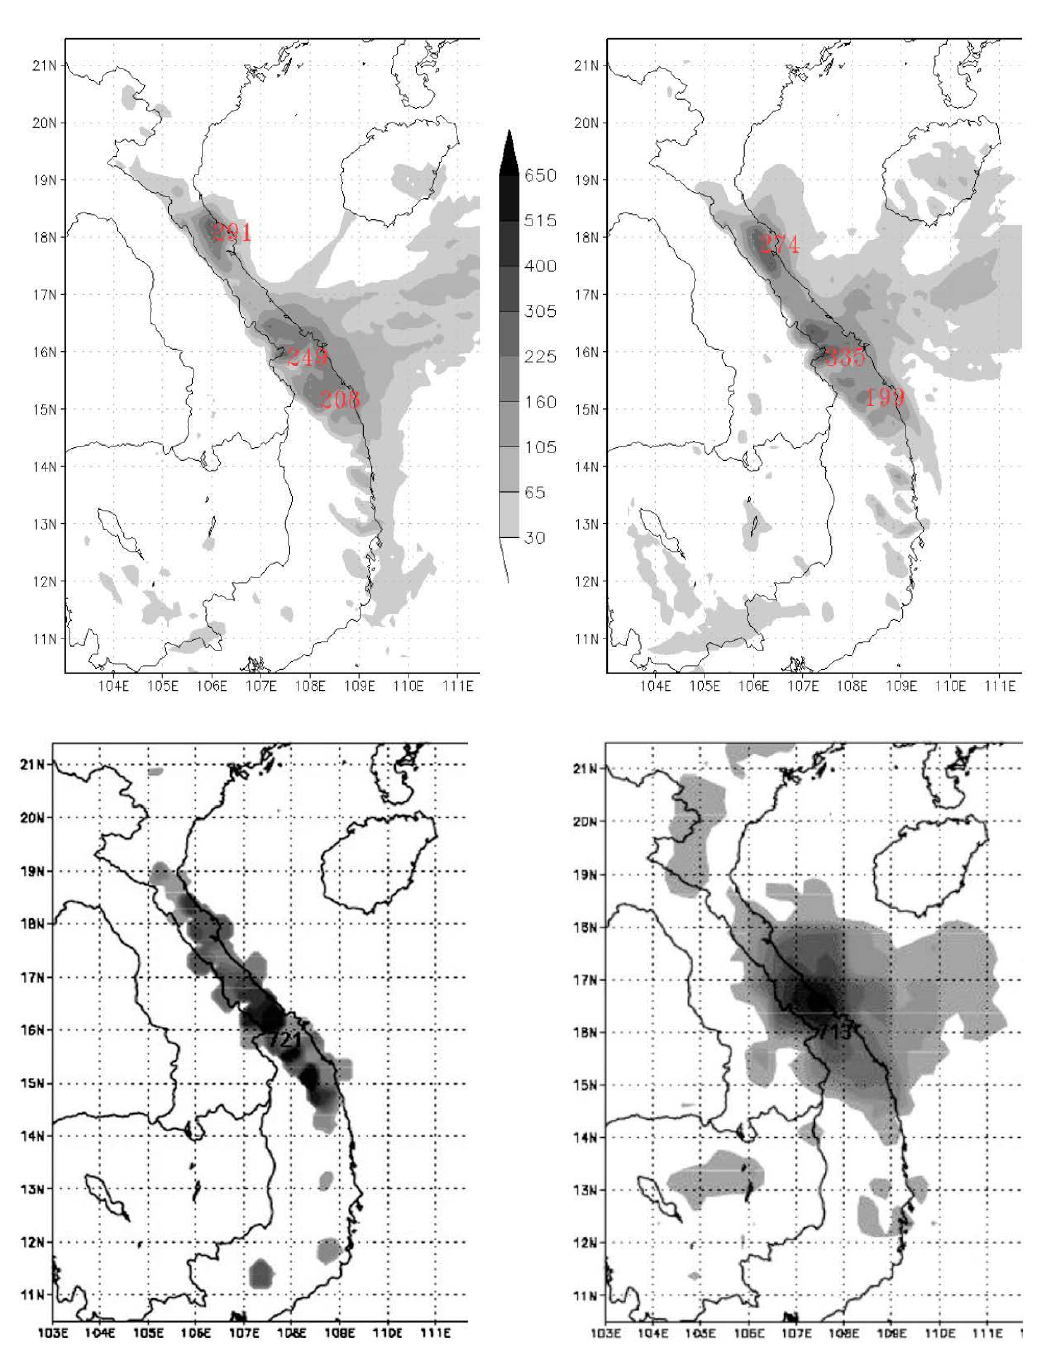
Figure 2. Accumulated precipitation (mm) for 48-h for Vietnam MCS case originally considered with RAMS model. Top : Equivalent WRF simulation results on domain 2 (10 km grid spacing) with native KF ( left ) and modified KF ( right ). Values of local precipitation maxima indicated in red. Bottom : Corresponding objective analyses of the observed gauge-derived precipitation ( left ), and TRMM data ( right ). Number in black is the absolute maxima at the location of the Thuong Nhat station (16.128° N, 107.688° E).